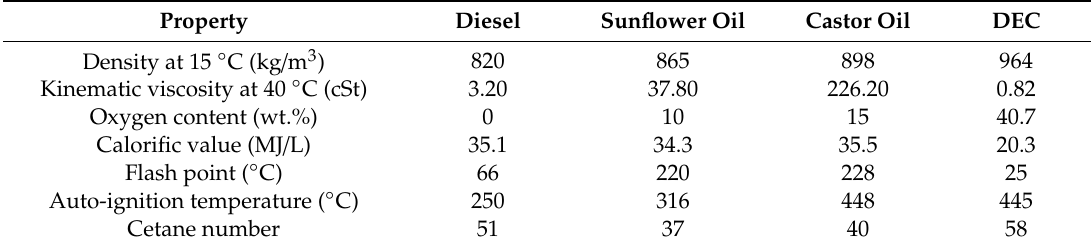
Table 1. Properties of diesel, sunflower oil, castor oil, and diethyl carbonate. Density and kinematic viscosity are experimentally obtained, whereas the other data are taken from the literature [27,31,32]. Property